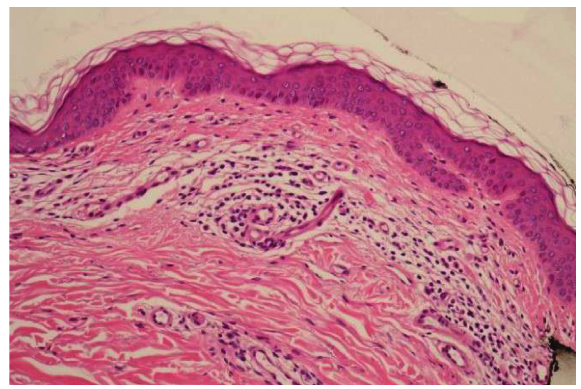
Figure 3: Signs of extensive regression in the superficial dermis, lacking atypical melanocytes (HE 20x).